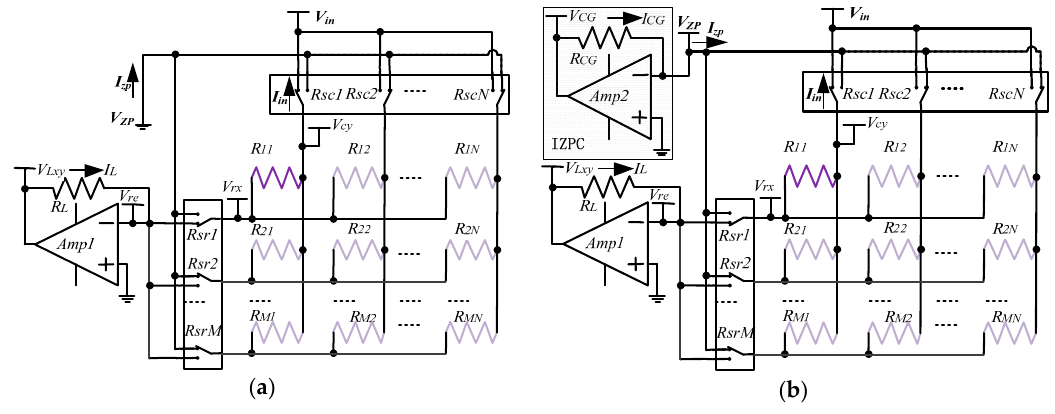
Figure 1. ( a ) Schematic of the basic S-NSE-ZPC; and ( b ) schematic of the improved